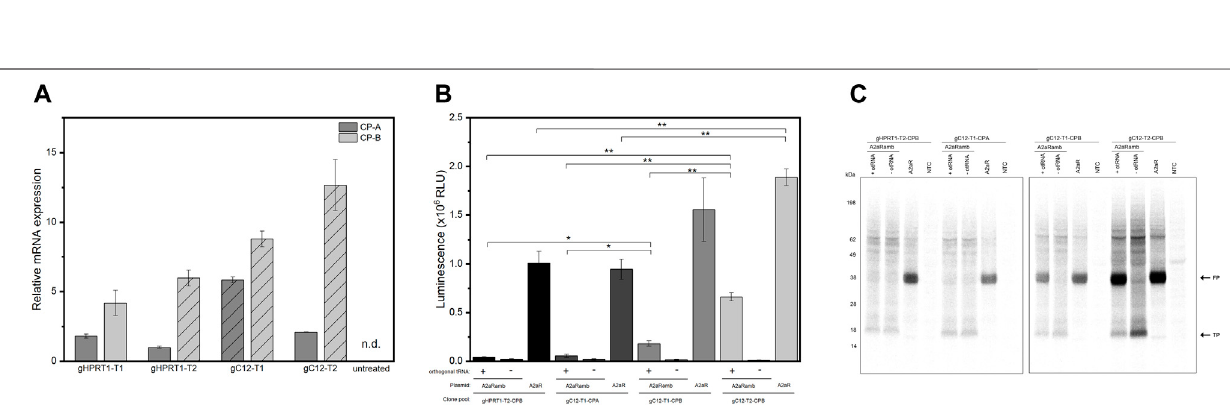
FIGURE3 | CHO cells stable transfected with GFP. CHO cells were stable transfected byCRISPR/Cas9 tointegrate GFP into the HPRT1 or C12orf35 locus. Cells weresubjectedtopuromycinselectionpressuretoenrichpositivelytransfectedcells.MicroscopicimagesofGFPclonepoolsareshown.Scalebarsfor HPRT1 measure 500 μ m, while scale bars for C12orf35 measure 100 μ m.